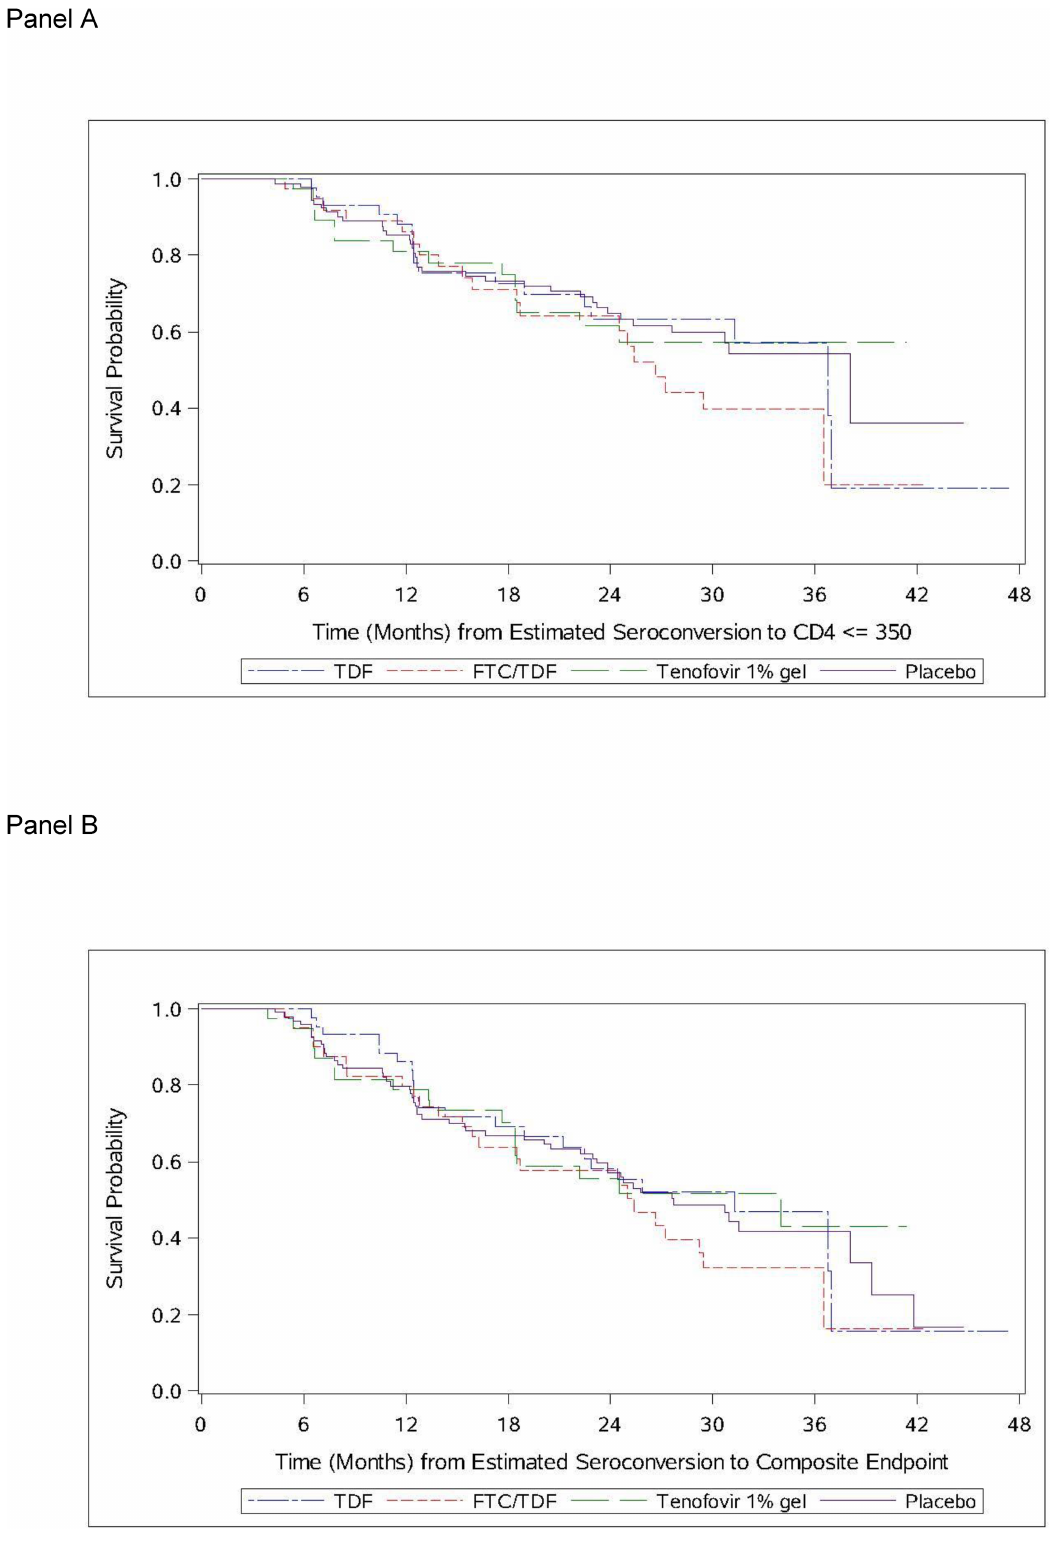
Fig 2. Time from HIV seroconversion to CD4+ T cell count (cid:20) 350 cells/mm 3 (Panel A). Time from HIV seroconversion to the composite endpointof CD4+ T cells (cid:20) 350 cells/mm 3 , initiationof ART or death (Panel B).